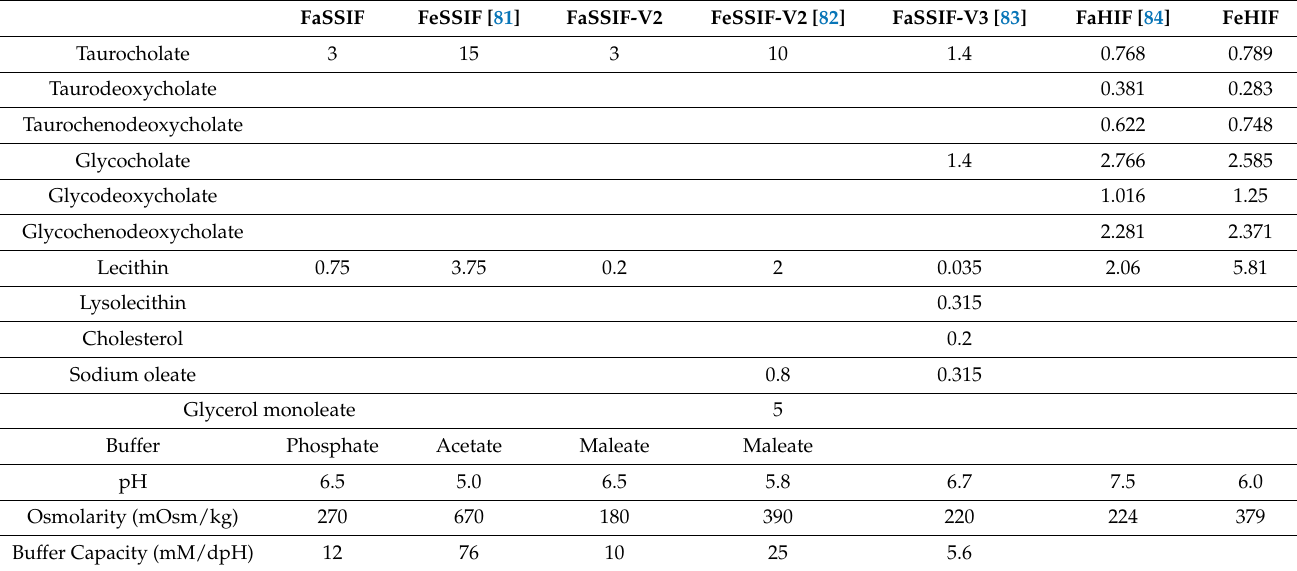
Table 3. The content and properties of several biorelevant media